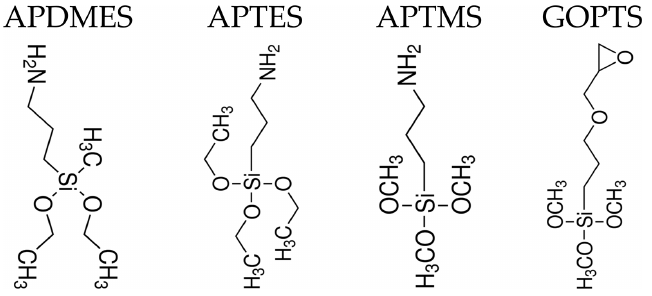
Figure 7. Chemical structures and abbreviations of the silanes mentioned in this review.